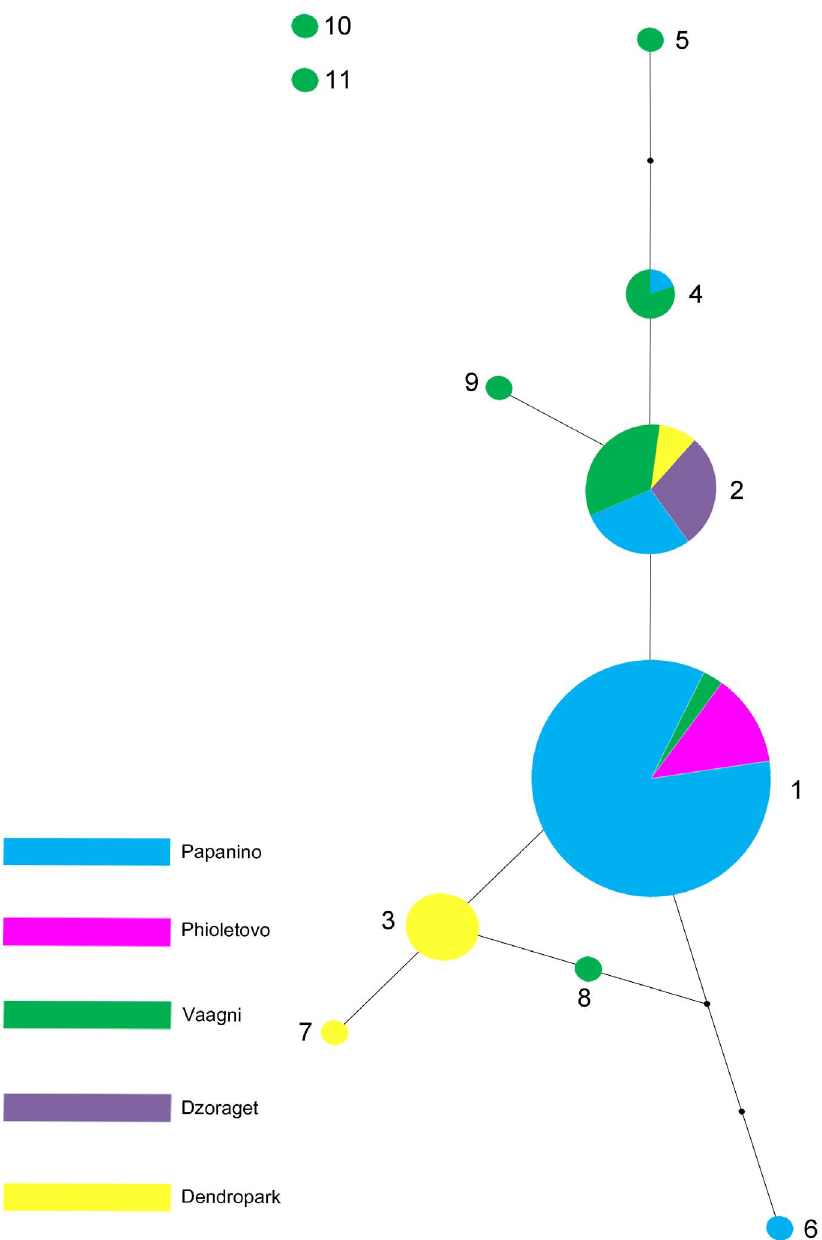
Figure 3. Schematic representation of the SP network that reflects relationship between genotypes 1–9 in D.dahli. Complete sequences of D. dahli genotypes were analyzed using TCS software version 1.21. Genotypes 10 and 11 are plotted separately. Population distribution of the genotypes is shown by different colours. The black circles show, unsampled, but computer-predicted genotypes.